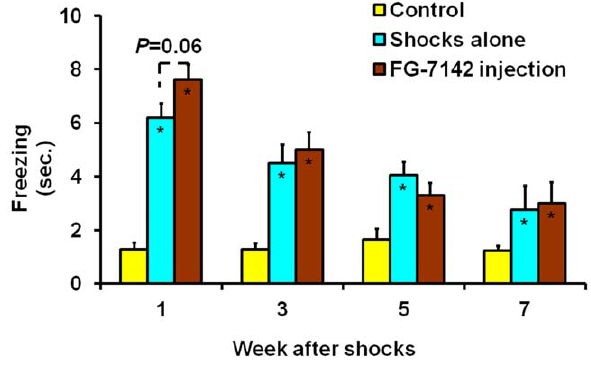
Values represent mean 6 SEM. **indicates significance at P , 0.01 from the control.